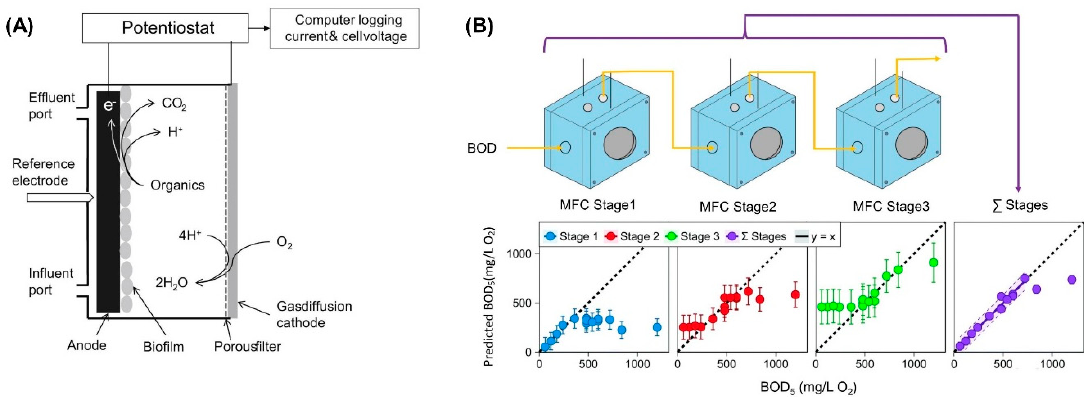
Figure 2. ( A ) Schematic diagram of the membrane-less single-chamber MFC-based BOD sensor [25]. ( B ) Schematic diagram of the three-stage MFCs as BOD sensor and compliance of predicted BOD 5 values with five-day BOD test (BOD 5 ). y = x is shown as the “ideal” prediction [57].